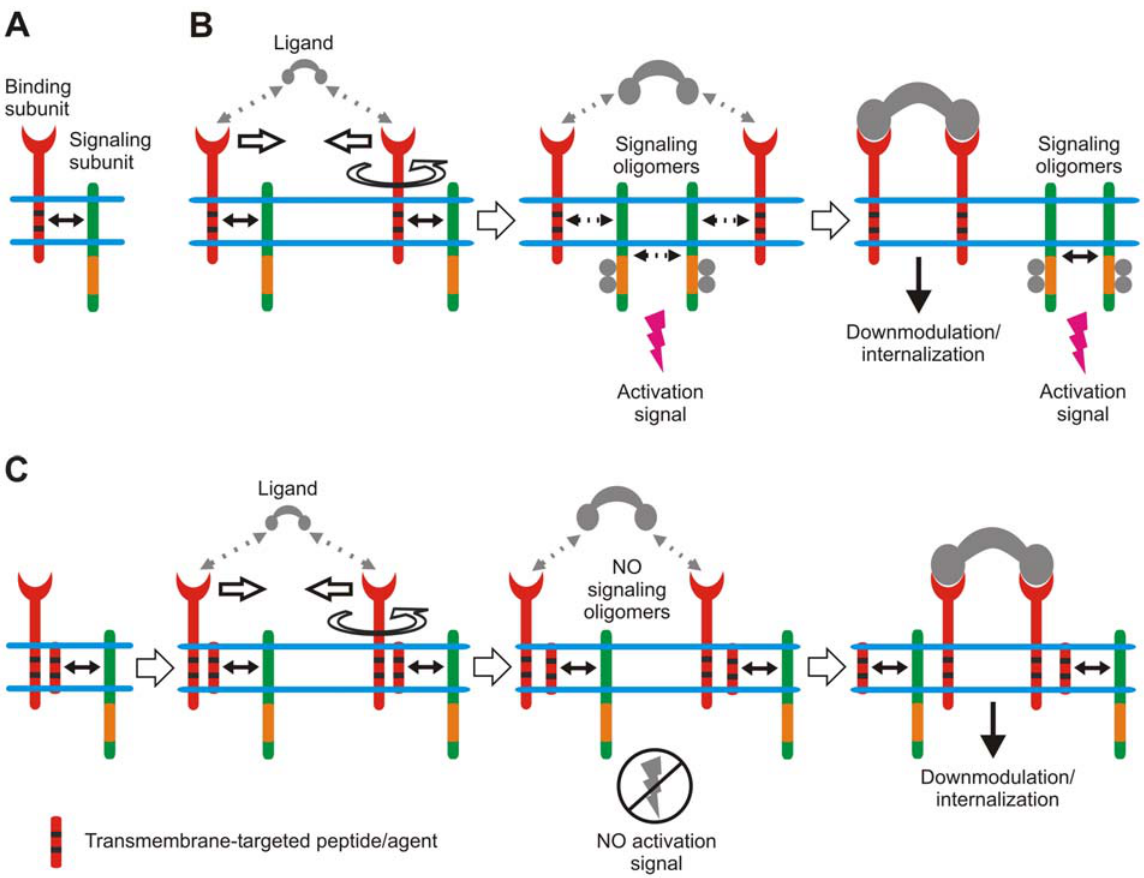
Figure 1. Novel model of immune signaling reveals a new target and tools for immunomodulatory intervention. (A) Multichain immune recognition receptor (MIRR) assembly. Binding and signaling subunits are shown in red and green, respectively. ITAMs are shown as orange rectangles. Transmembrane interactions between MIRR ligand-binding and signaling components (shown by solid arrow) play a key role in receptor assembly and integrity on resting cells. (B) The signaling chain homooligomerization (SCHOOL) model, which proposes that the homooligomerization of signaling subunits plays a central role in triggering MIRRs. Small solid black arrows indicate specific intersubunit hetero- and homointeractions between transmembrane and cytoplasmic domains, respectively. Circular arrow indicates ligand-induced receptor reorientation. All interchain interactions in a dimeric intermediate are shown by dotted black arrows reflecting their transition state. Phosphate groups are shown as dark circles. (C) Molecular mechanisms underlying proposed immunomodulatory intervention by transmembrane-targeted agents. Specific blockade of transmembrane interactions between MIRR recognition and signaling subunits results in ‘‘predissociation’’ of the receptor complex, thus preventing formation of signaling oligomers and inhibiting ligand-dependent immune cell activation. In contrast, stimulation of these predissociated MIRRs with cross-linking antibodies to signaling subunits should still lead to receptor triggering and cell activation (not shown).